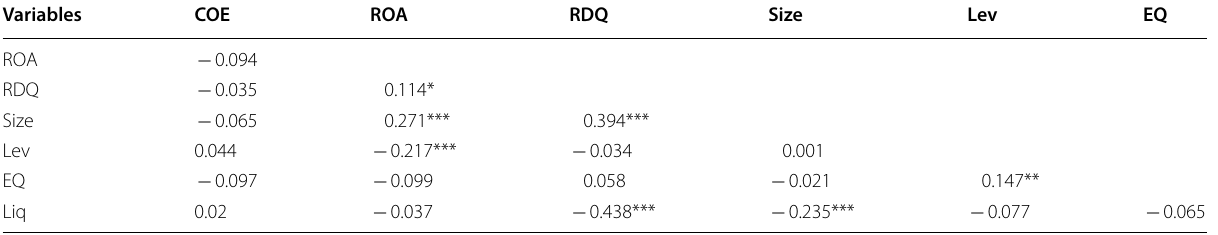
No serious multicollinearity among the independent variables *Significant at level 10%, **Significant at level 5%, ***Significant at level 1% Table 5 Multiple regression results